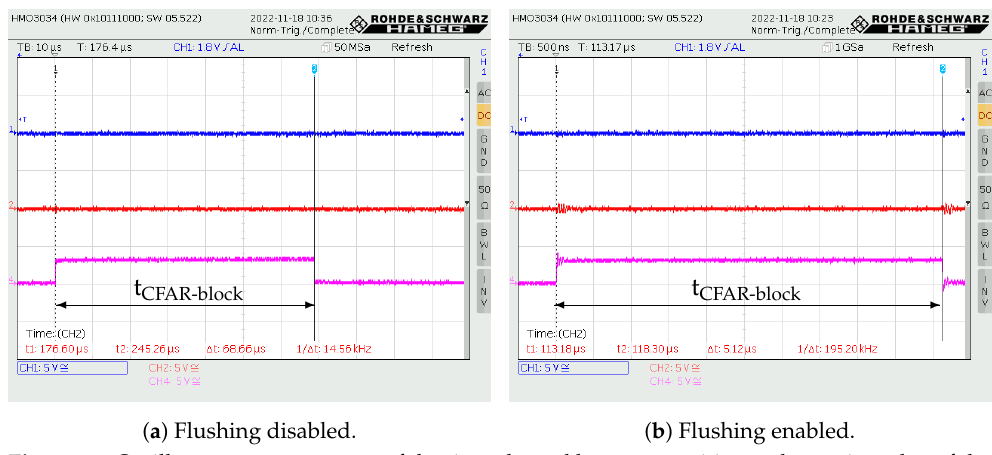
Figure 19. Oscilloscope measurement of the time elapsed between positive and negative edge of the S_OUT (bottom) signal when flushing is ( a ) disabled and ( b ) enabled. This value is equal to the single data block duration at the output of the early obstacle detection